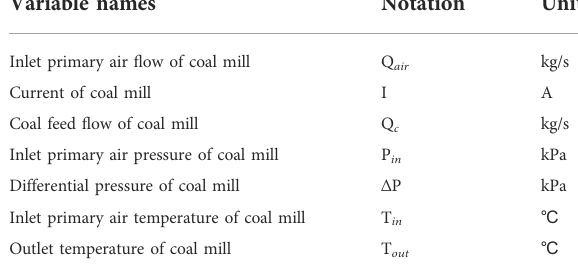
TABLE 1 Variables